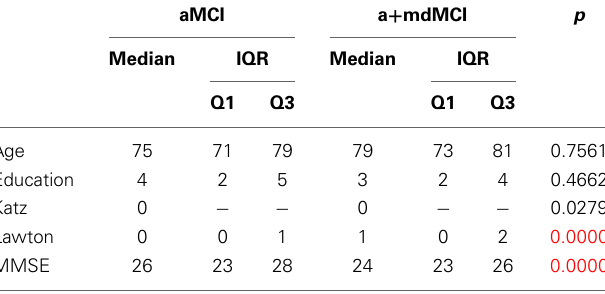
Table 6 | Additional description of socio-demographic data for the MCI subtypes, and the four groups comparison.